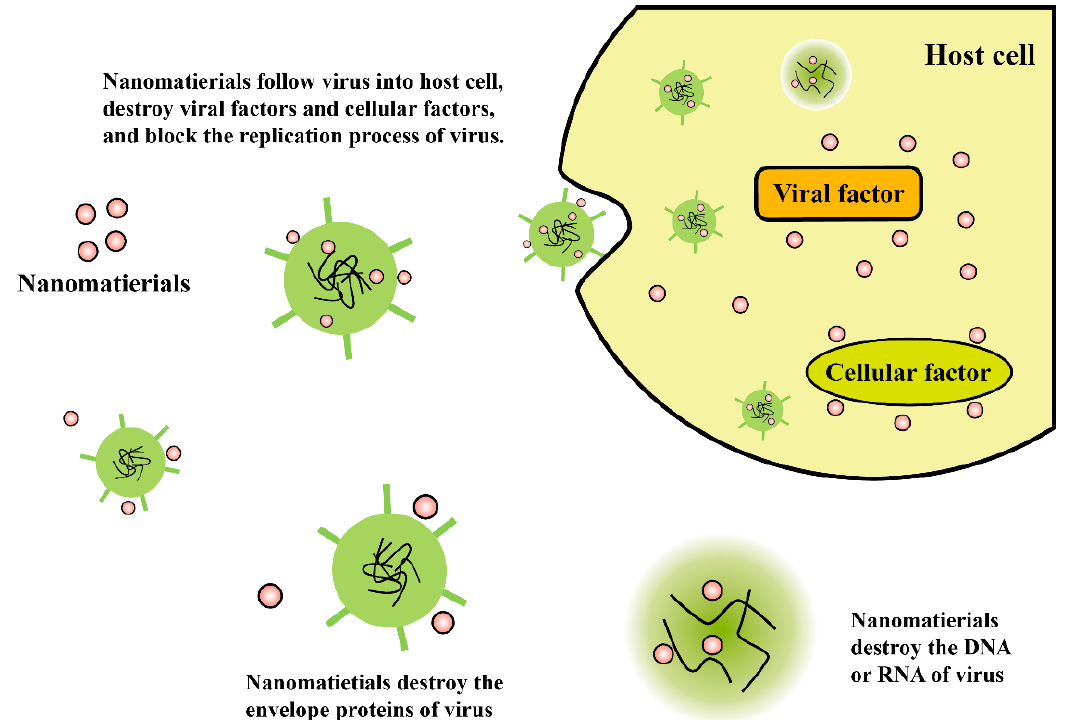
Figure 4. Illustration of antiviral mechanisms of functional nanomaterials.